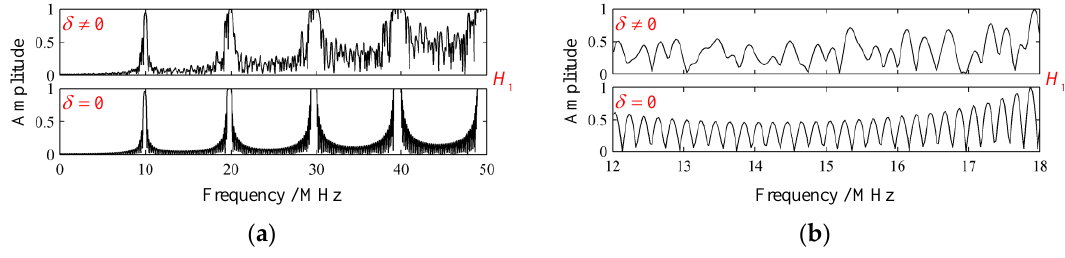
H without attenuation . ( a ) 1